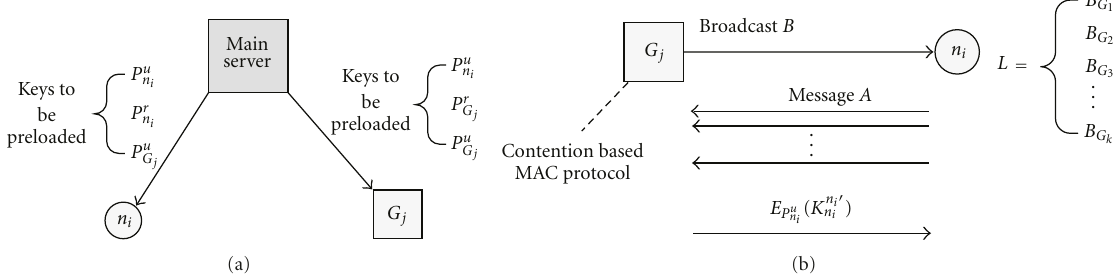
Figure 2: An illustration of information exchange prior to and after deploying sensor nodes and gateways: (a) embedding keys into gateways and sensor nodes, (b) information exchange between sensor nodes and gateways during secure